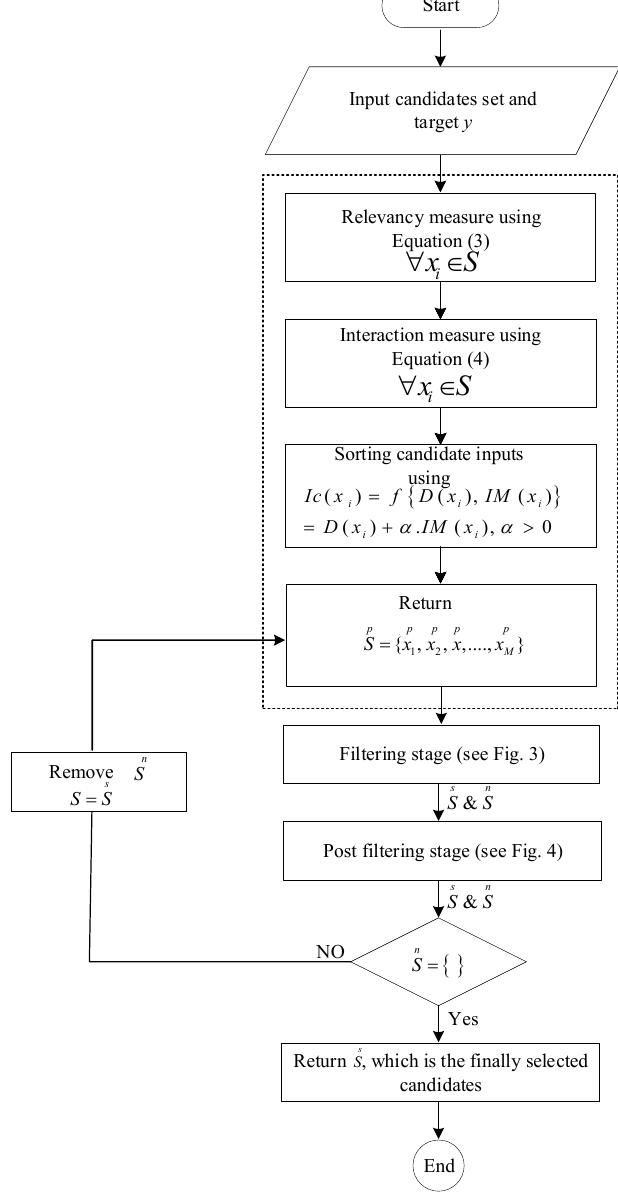
Figure 2. Flow chart of the modified feature selection technique.